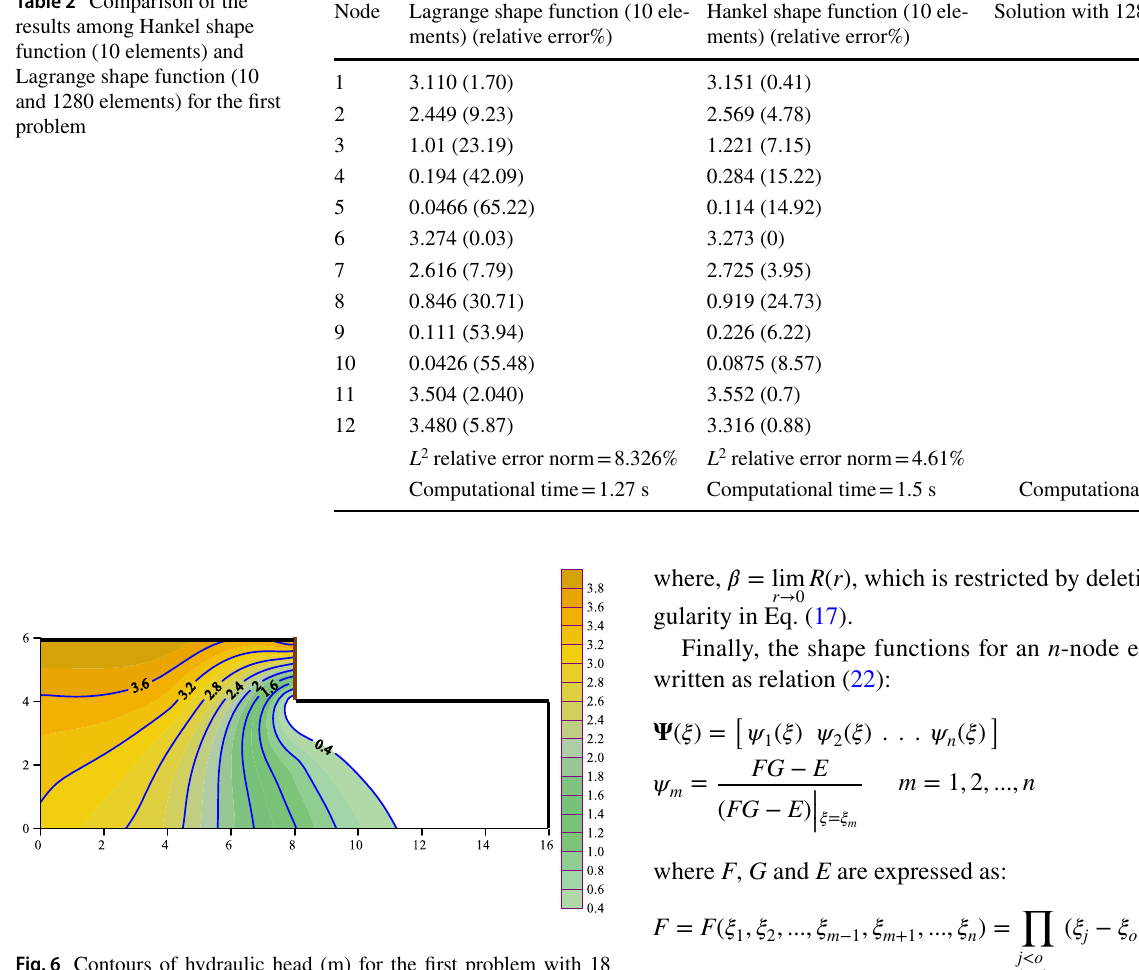
Fig. 6 Contours of hydraulic head (m) for the first problem with 18 nodes